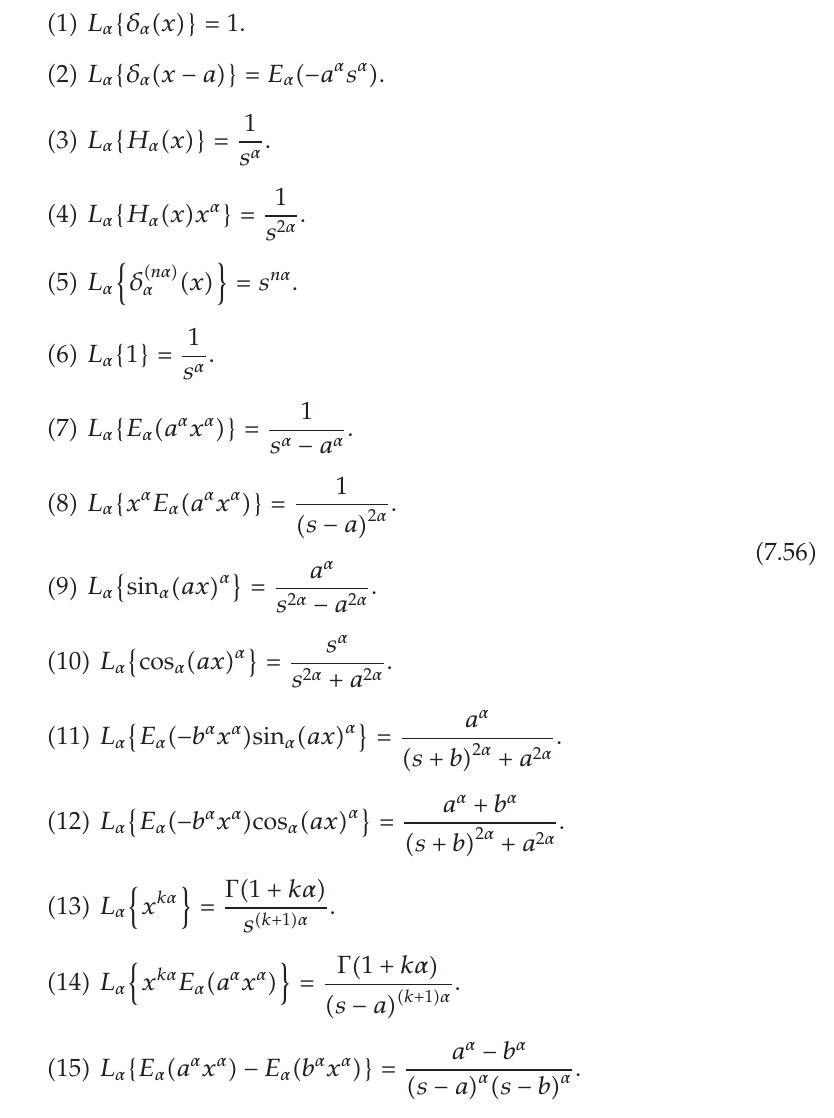
Table of the Yang-Laplace Transform of Elementary Functions